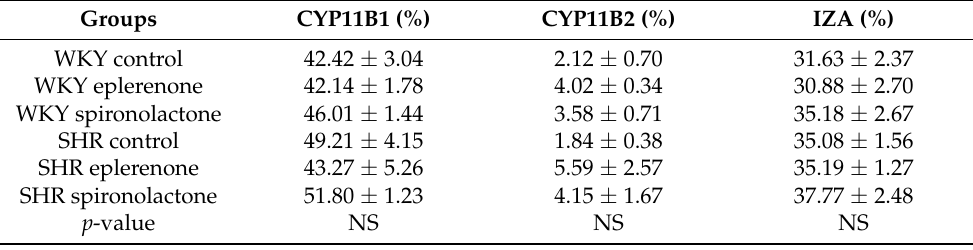
Table 1. Percentage of stained area of aldosterone synthetase (CYP11B2), 11 β -hydroxylase (CYP11B1), inner zone antigen (IZA), in the adrenal cortex of Wistar Kyoto (WKY) and Spontaneous Hypertensive rats